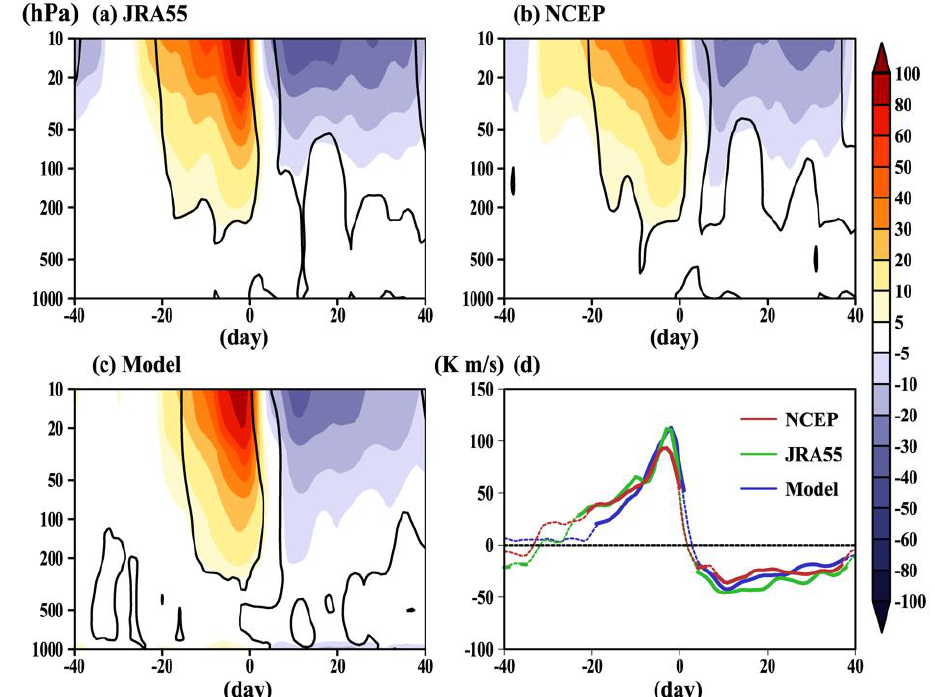
Figure 9. Composite evolution of eddy heat flux area-averaged in the 45° – 75° N latitude band from 1000 – 10 h Pa (shadings; units: K m/s) from day −40 to day 40 relative to the SSW onset date for ( a ) the JRA55 reanalysis, ( b ) the NCEP/NCAR reanalysis, and ( c ) CESM1-WACCM. Black contours indicate that the composite anomalies are significant at the 95% confidence level. The last plot ( d ) shows the temporal evolution of eddy heat flux at 10 h Pa (units: K m/s) from the JRA55 reanalysis ( green ), the NCEP/NCAR reanalysis ( red ) and CESM1-WACCM ( blue ), receptively. Thickened solid parts of the line indicate the composite is significant at the 95% confidence level according to the t -test.